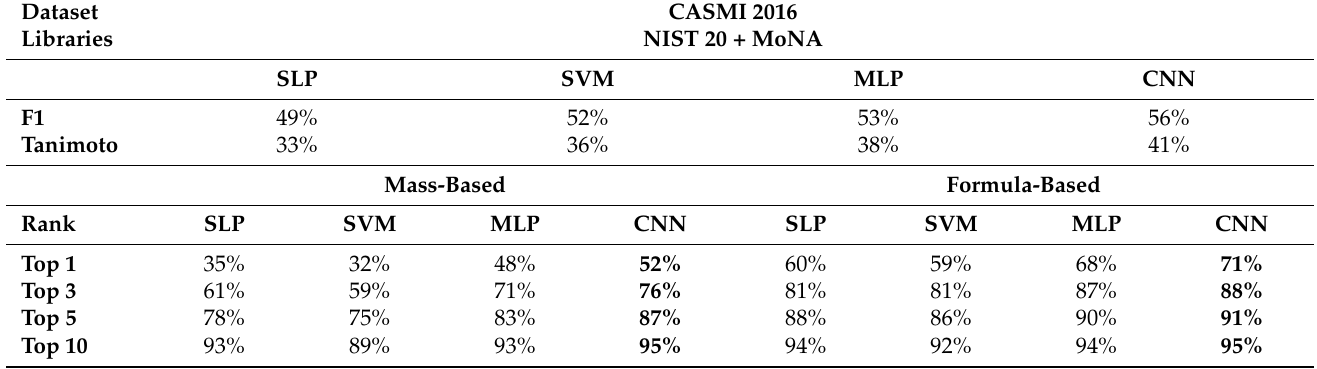
Table 2. Performance comparison of SLP, MLP, SVM, and CNN models that were trained using MS/MS spectra acquired from NIST 20 and MoNA and tested on the CASMI 2016 dataset. F1 score, Tanimoto similarity score, and top- k ranking of metabolite candidates are calculated for mass-based and formula-based approaches. The result of the best performing model under each category is shown in